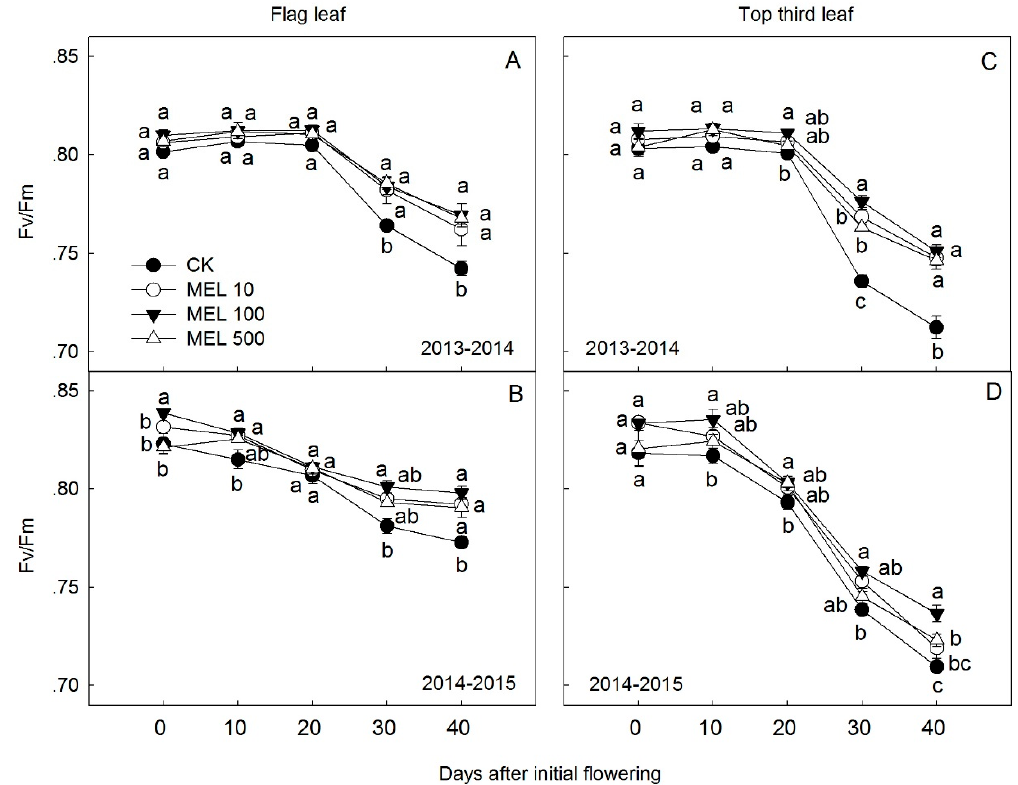
Figure 6. The effects of MEL application on Fv/Fm ratio after 0, 10, 20, 30 and 40 days of initial flowering. ( A , B ) are the Fv/Fm ratio of flag leaves in the 2013–2014 and 2014–2015 growing seasons, and ( C , D) are for the top third leaves in two growing seasons. Values are means ± SEs of four replicates. Significant differences between different treatments on the same day of the experimental period are indicated by different letters ( p < 0.05).